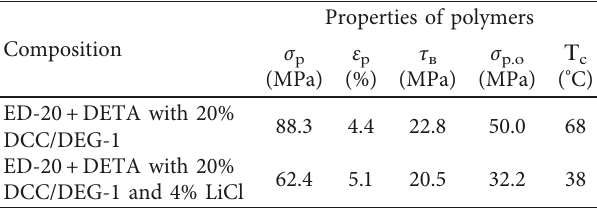
Table 5: Effect of blocking of urethane groups by LiCl on the epoxy polymer